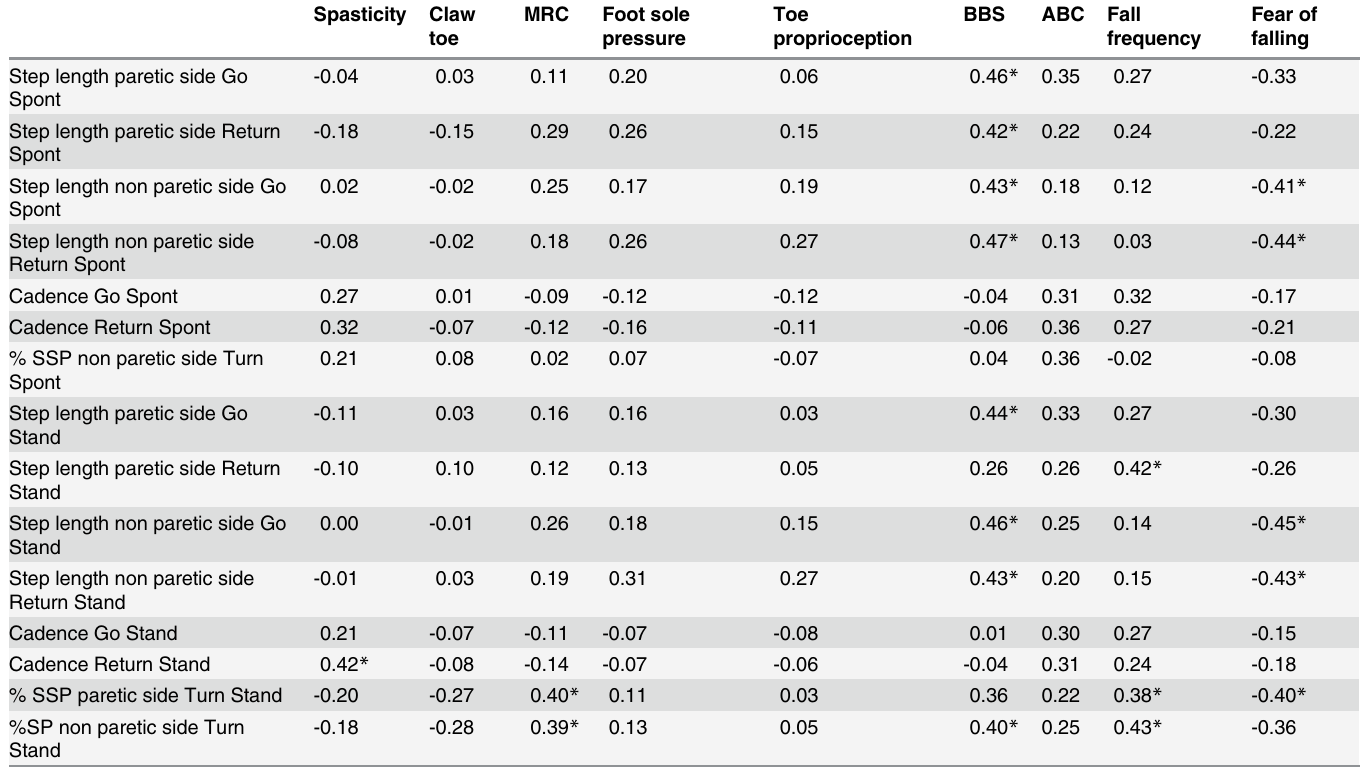
Table 4. Correlation between Oriented gait and Turn performance explanatory spatiotemporal and kinematic parameters from the stepwise analy- sis and the clinical data.